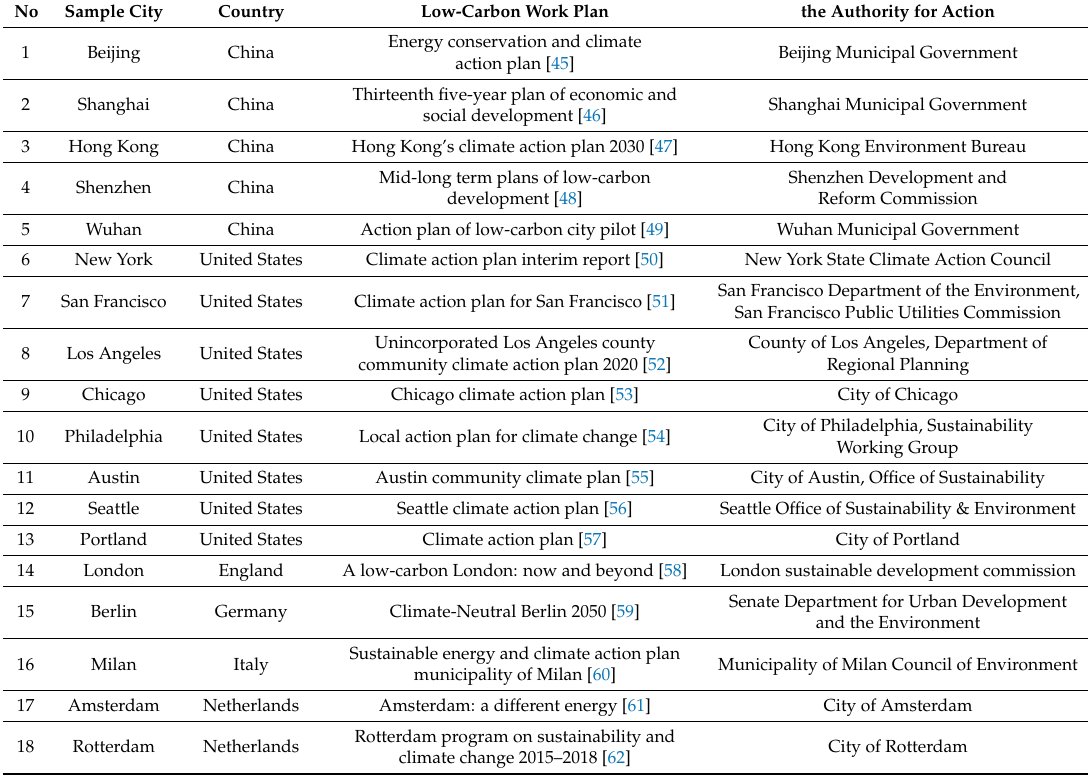
Table 8. Work plan for promoting low-carbon